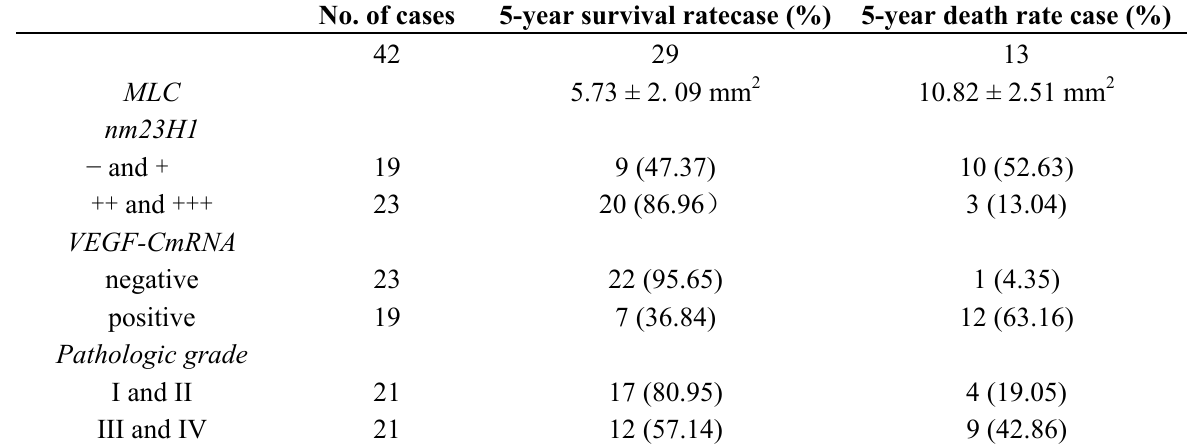
Table 3. Relationship between nm23H1, VEGF-C mRNA expression, and MLC, and survival rate in PCa